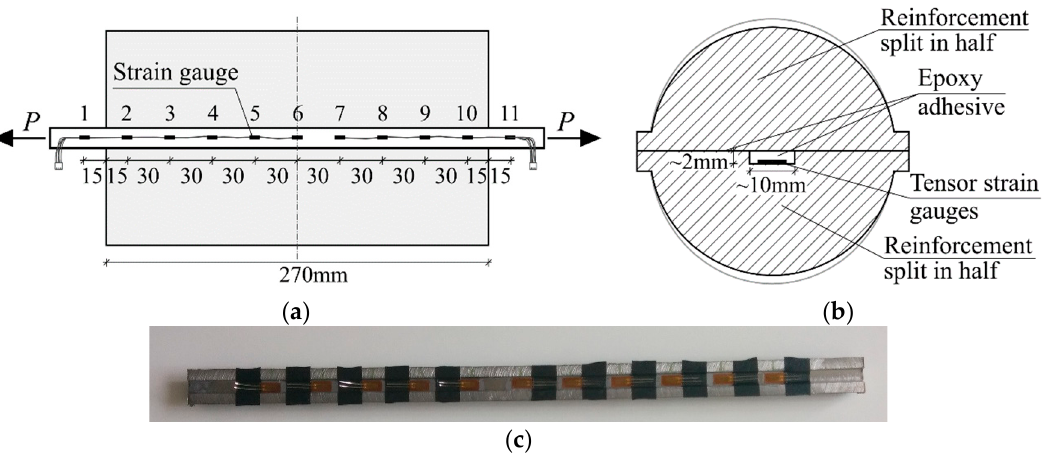
Figure 1. Installation and spacing of strain gauges: ( a ) Longitudinal layout; ( b ) sectional view of the reinforcement bar; and ( c ) strain gauges within one half of the reinforcement bar.